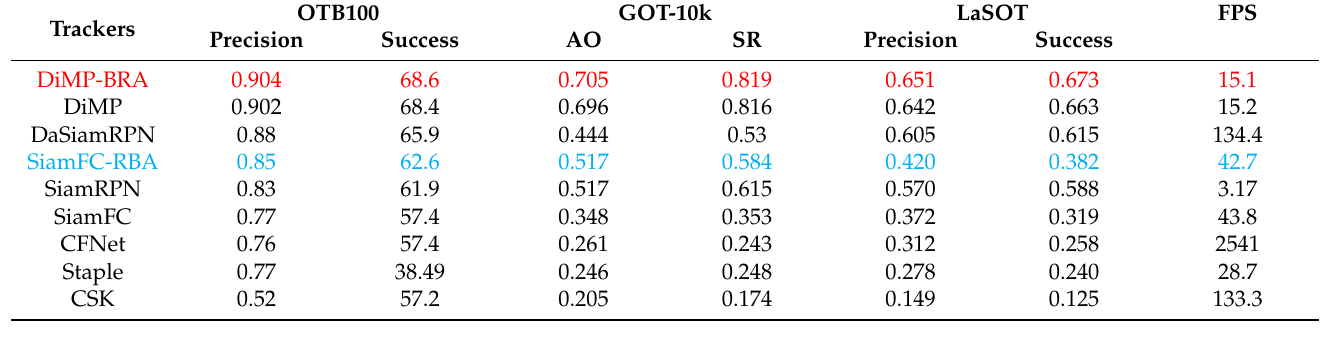
Table 1. Comparison between the proposed method and baseline trackers on the OTB100, GOT-10k and LaSOT benchmarks. Red and blue indicate the two trackers that use the proposed response behaviour analysis method.